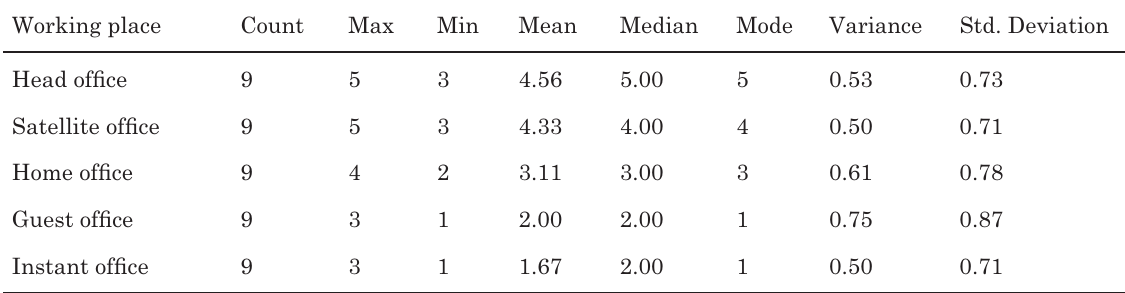
Table 5. Accessibility of ICT services and organisation data Working